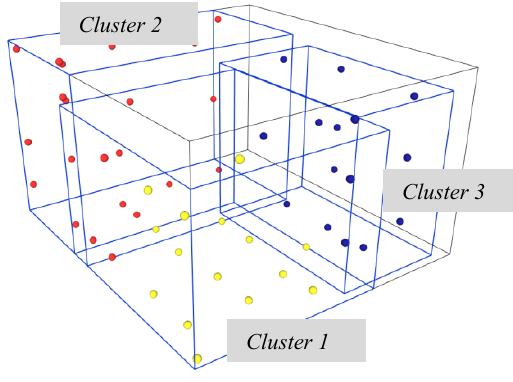
Figure 2. Parallelepiped of group clusters k = 3.